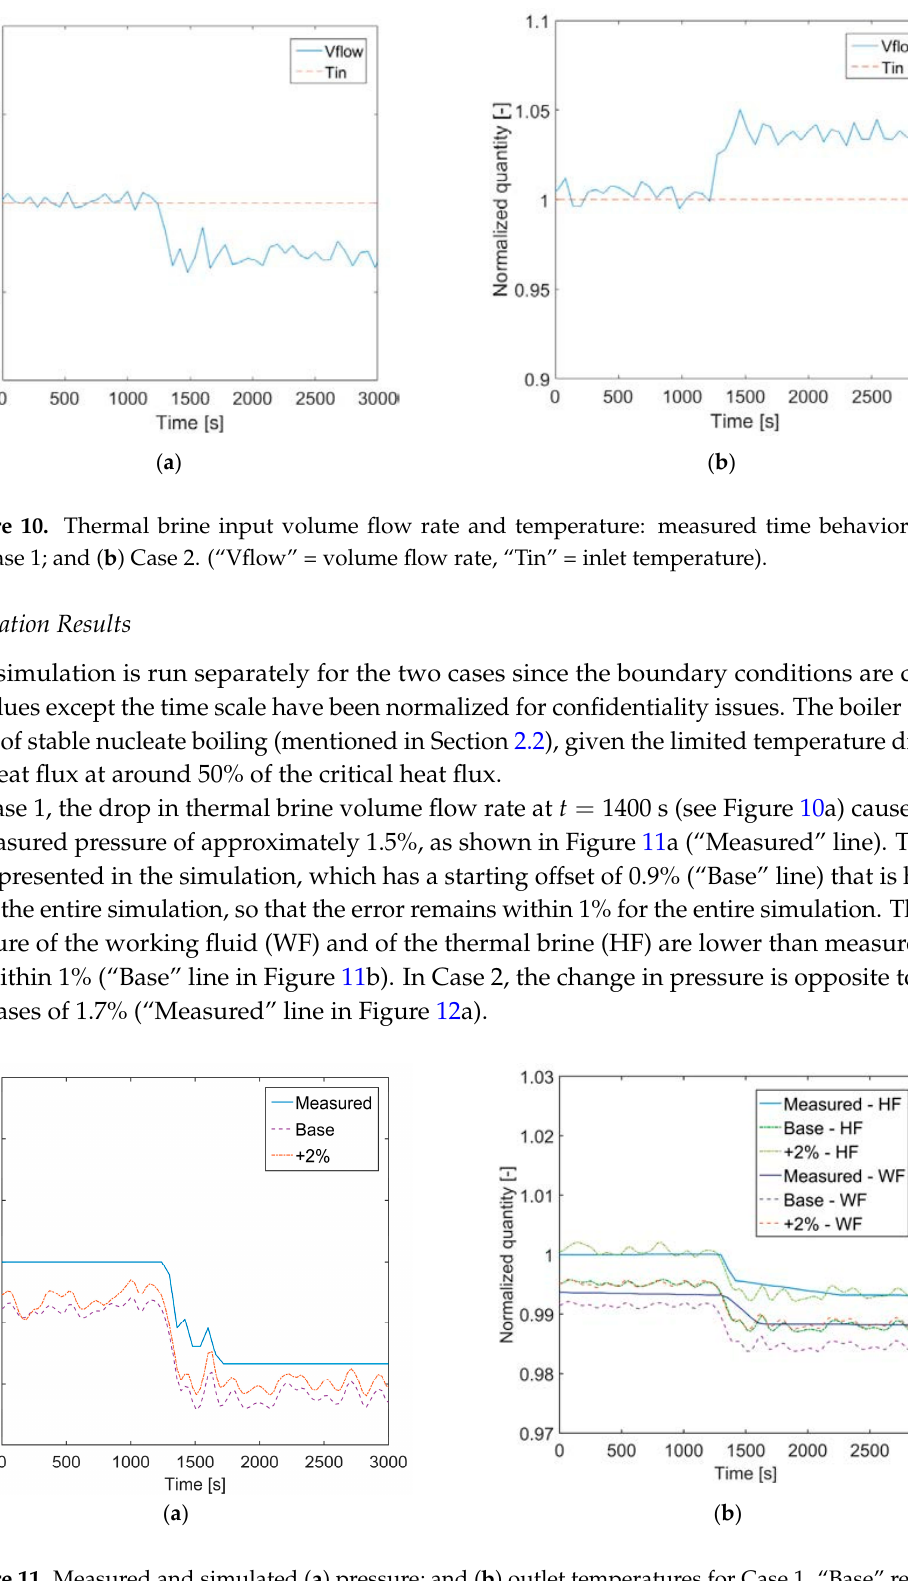
Figure 11. Measured and simulated ( a ) pressure; and ( b ) outlet temperatures for Case 1. “Base” refers to the thermal brine inlet volume flow rate as measured, whereas “+2%” to increase of the latter of 2% (HF: Heating fluid, WF: working fluid).